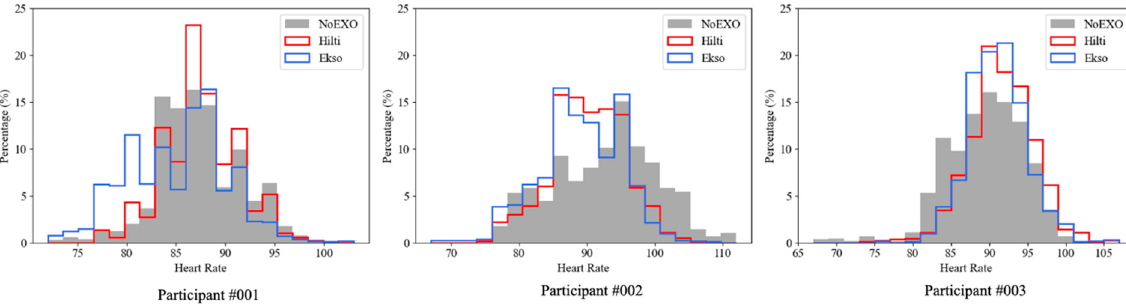
Figure 15. Distribution of the heart rates for individual participants during Task 2.